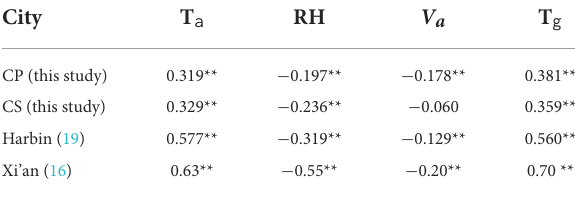
respondents was 0.26 clo and 0.32 clo for the Xinghai Park and Xi’an Road, respectively (Appendix B, Table B1).